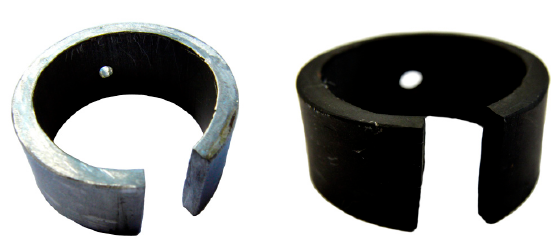
Figure 9. Depiction of the Inconel 600 alloy ring: before ( left ) and after the oxidation-lithiation process ( right ).